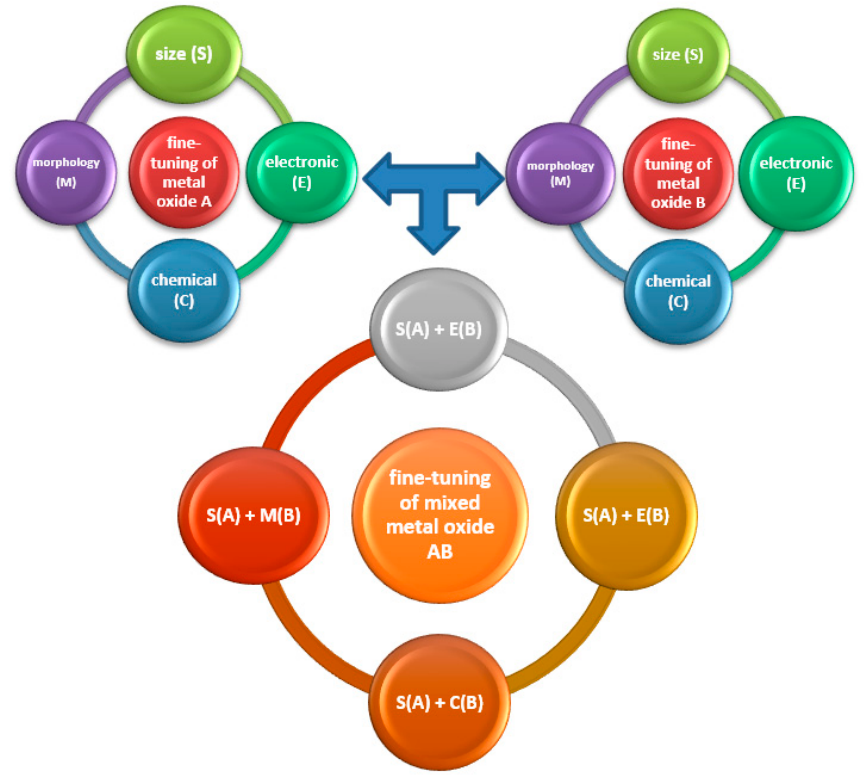
Figure 3. Indicative pathways towards the fine-tuning of a binary metal oxide of the general formula AB by adjusting the size (S), morphology (M), electronic (E) and chemical (C) state of one or both of the individual counterparts A and B. For instance, CuO x (A)/CeO 2 (B) binary oxides of different reactivity can be obtained by combining the morphology engineering of CeO 2 {denoted as M (B)} with the size engineering of CuO x {denoted as (S (A)} or by combining both the size and morphology engineering of both counterparts {S(A) + M(A) + S(B) + M (B)}. The scheme is just indicative of the different approaches that can be followed to adjust the local surface chemistry of MOs, without exhausting the margins of all possible combinations.